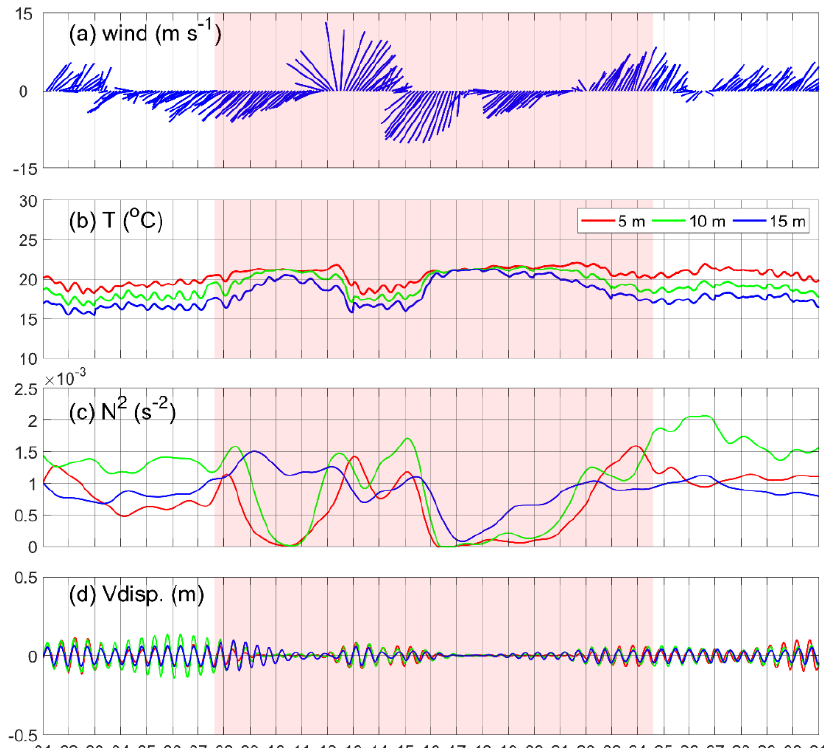
Figure 3. Timeseries of ( a ) 10-m wind from the Japan Meteorological Agency Meso-Scale Model (JMA/MSM) at the grid point of DR_M nearest to the observation site; timeseries of ( b ) temperature, ( c ) buoyancy frequency, and ( d ) semidiurnal vertical displacement at depths of 5, 10, and 15 m, from the nearest grid point of the DR_M, (depth of 81 m) to the ocean buoy (depth of ~20 m). Red, green, and blue lines denote depths of 5, 10, and 15 m, respectively. The reddish highlight denotes the period of the ADCP observation.